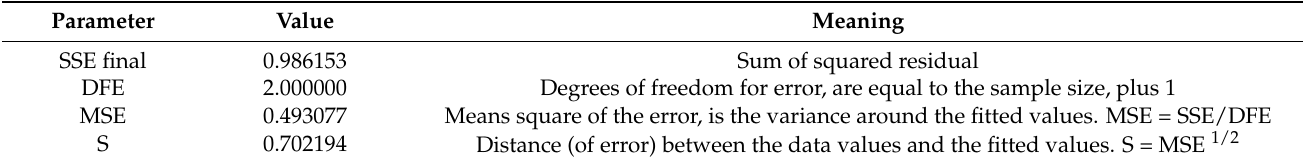
Table 5. Statistical summary of the fit